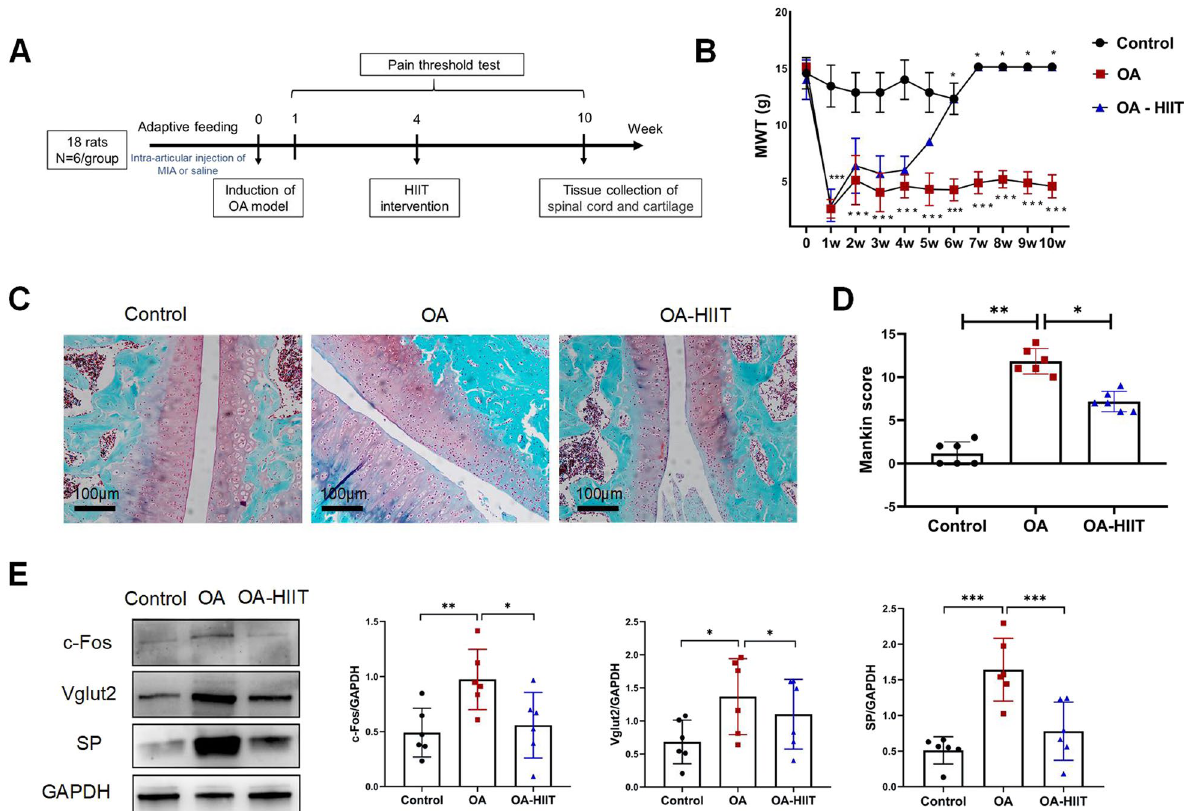
Fig. 1 HITT attenuates OA-induced hyperalgesia. A Research design and timeline. Twelve rats received an MIA injection to build an OA model after 1 week of adaptive feeding and exercise. Six rats received saline injections as control group. After 4 weeks, OA-HIIT rats were subjected to the HIIT treatment for six consecutive weeks, and control rats and OA rats exercised freely on the closed treadmill. Pain thresholds were assessed weekly in all rats, and the right knee joint and spinal cord was extracted after the 10th week. B The von Frey testing detected rats’ mechanical withdrawal threshold (MWT). n 6/group, repeated measures analysis of variance. Tukey and Bonferroni tests method was used as a post hoc test. C , D = Representative Safranin-O Fast green staining image (scale bar 100 μm) and Mankin score of cartilage (n 6 /group). Blue staining for bone and = = red staining for cartilage. One-way analysis of variance, the Tukey and LSD tests method was used as a post-hoc test. E Representative western blot image of spinal cord tissue ( L4–L5) and quantitative analysis of c-Fos, Vglut2, and SP ( n 6 /group). One-way analysis of variance, the Tukey and LSD = tests method was used as a post hoc test. * P < 0.05, ** P < 0.01, *** P < 0.001 as